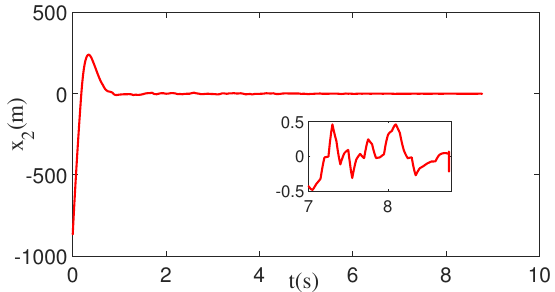
Figure 10. The change in ZEM with white noise and constant